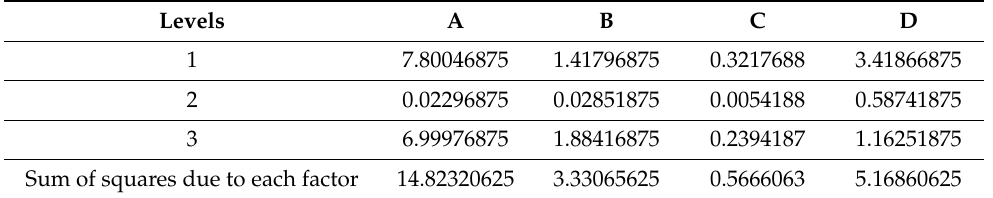
Table 9. Average of n and sum of squares due to each factor.